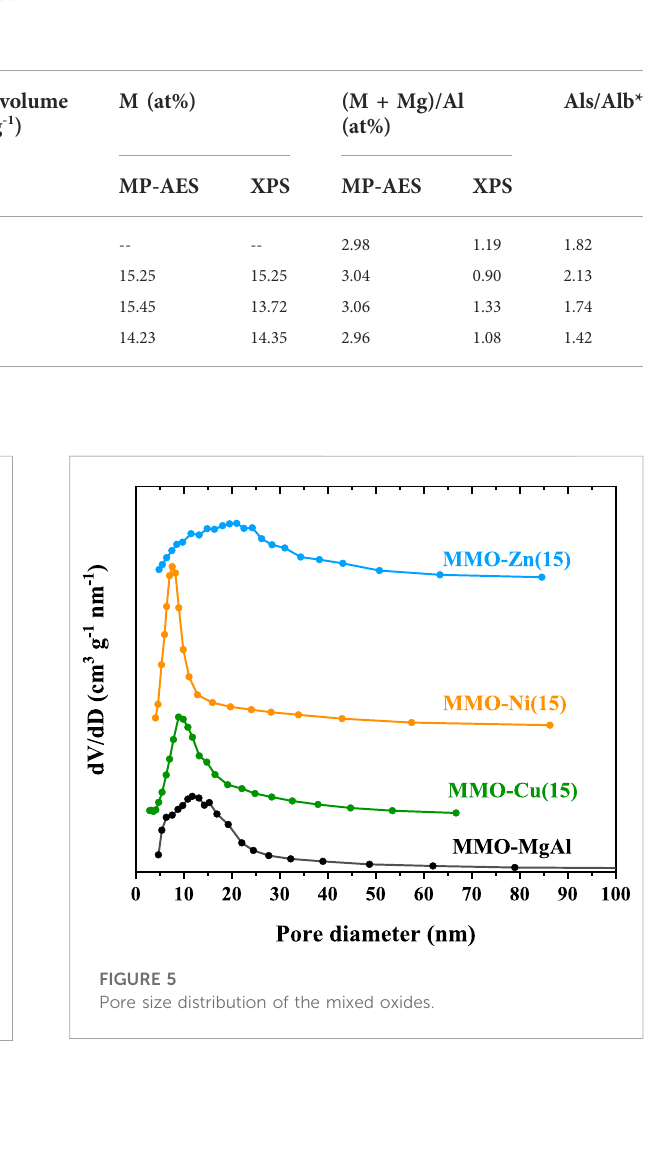
TABLE 2 Textural properties and metallic composition of the materials.